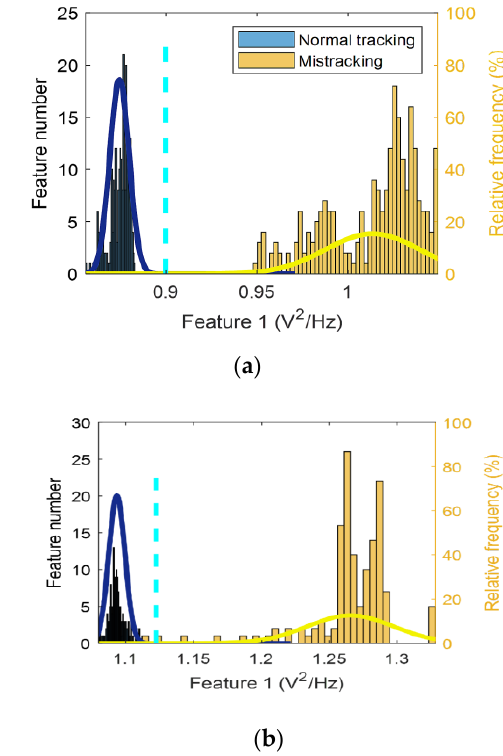
Figure 7. Histograms, probability density functions, and diagnostic thresholds (represented as aqua dotted lines) for ( a ) no-load (see Figure 5) and ( b ) 20 kg load (see Figure 6) conditions.